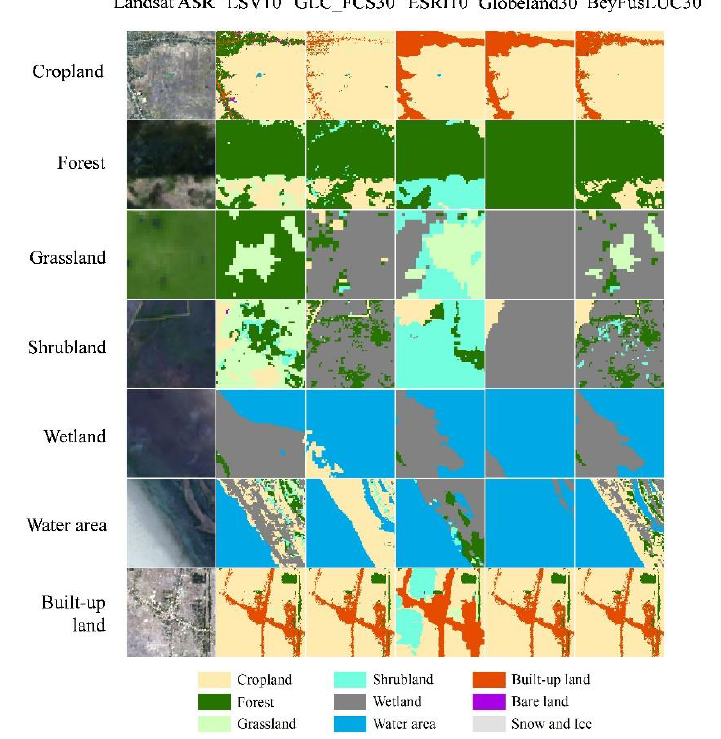
Figure 5. Comparison of the LUC datasets with remote sensing image.